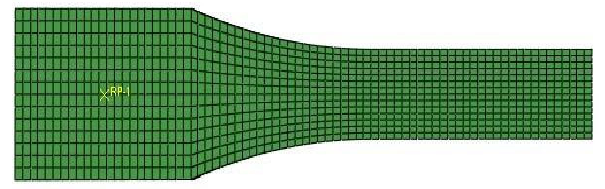
Figure 3. Specimen model for the numerical tensile test.